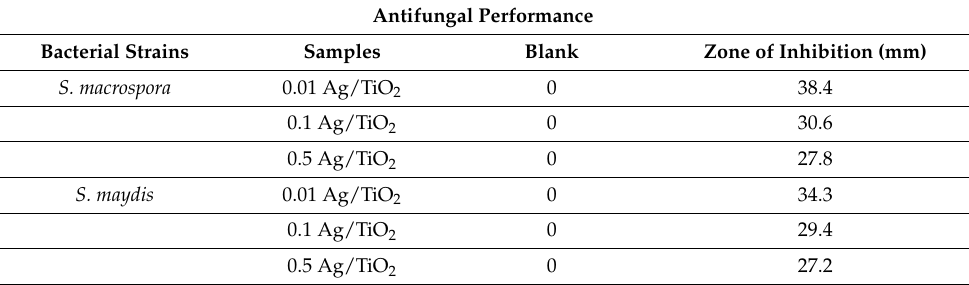
Table 4. Zones of inhibition for the antifungal activity of 0.01 Ag/TiO 2 , 0.1 Ag/TiO 2 , and 0.5 Ag/TiO 2 nanocomposites were determined using the Agar Well cut diffusion